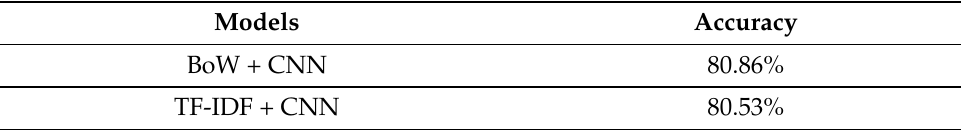
Table 11. Comparison of CNN models on BoW and